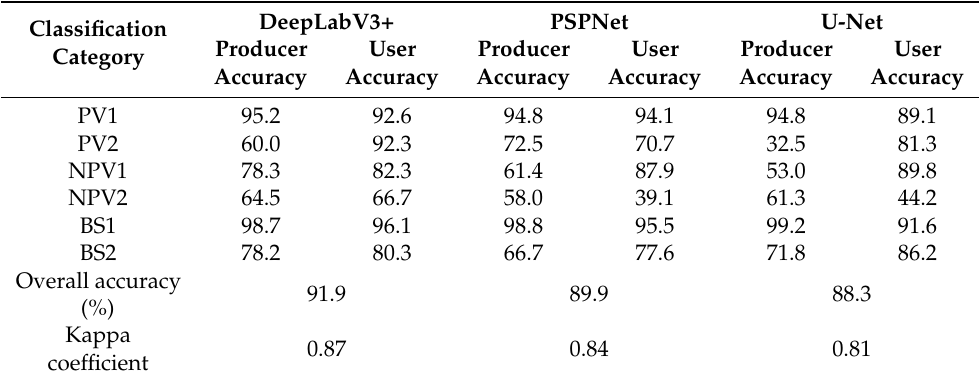
Table 2. Accuracy of the results under different semantic segmentation networks.